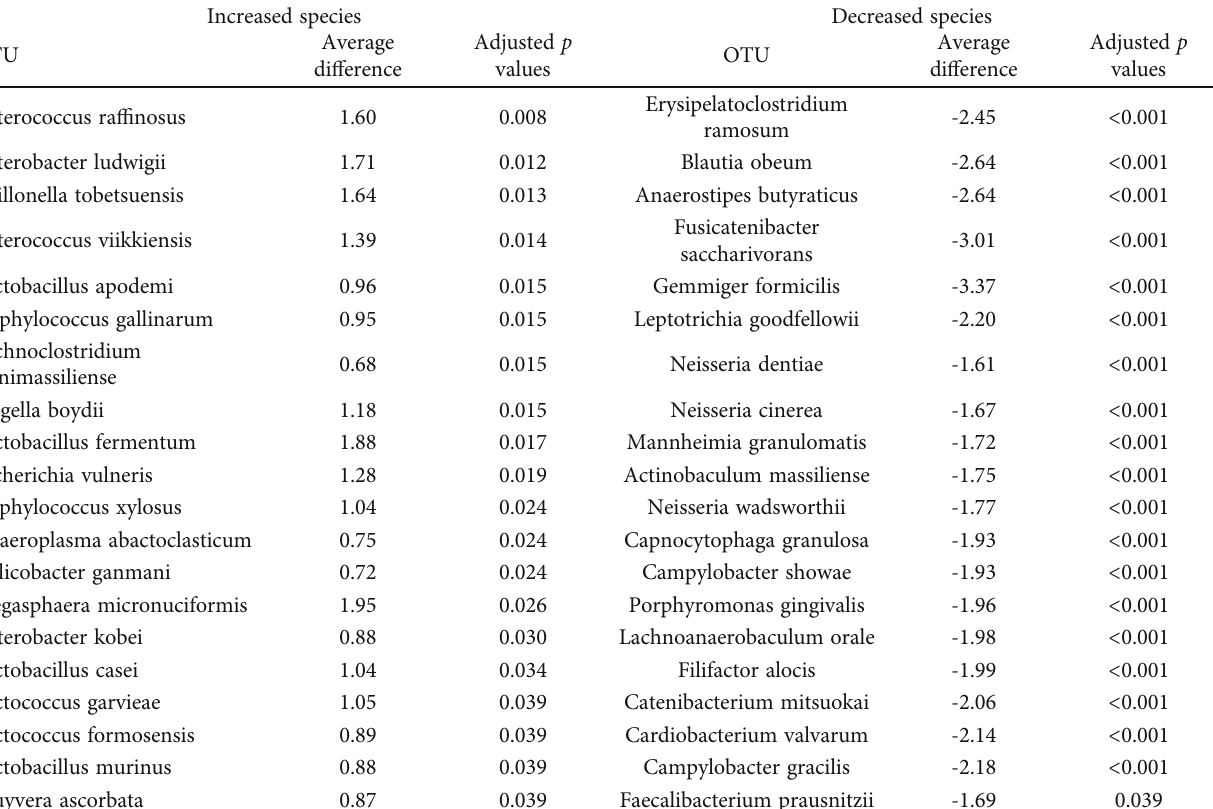
Table 4: Top 20 increased/decreased species with the signi fi cant di ff erence in the poststroke